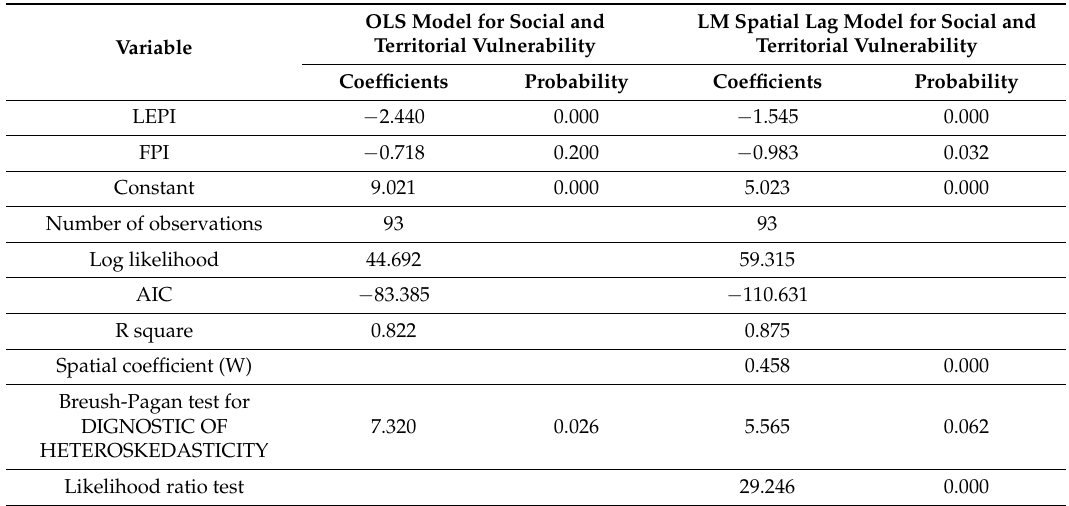
Table 5. OLS model and LM Spatial Lag model to assess the association between LP and LEPI and FPI. (Source: Authors’